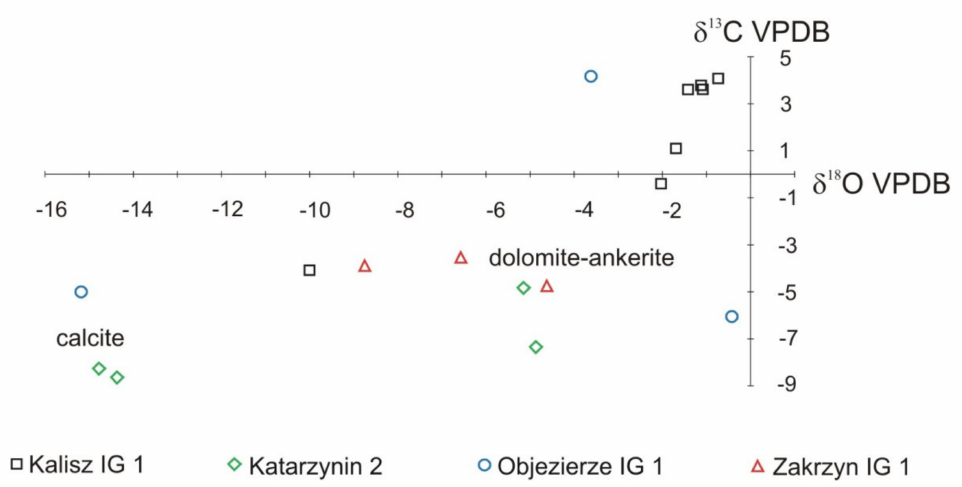
Figure 5. δ 18 O‰ VPDB versus δ 13 C‰ VPDB plot of carbonate minerals studied in four